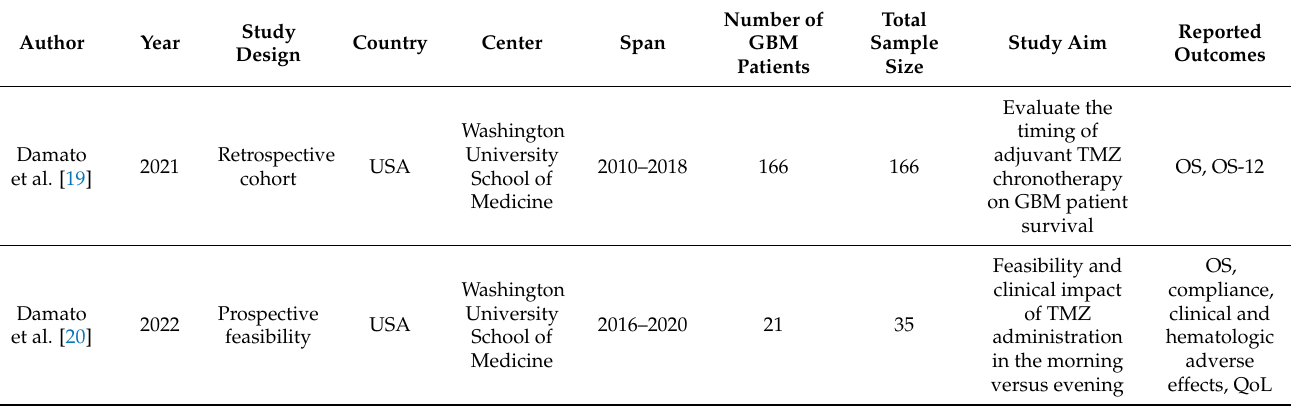
Table 1. Key study characteristics studies included for